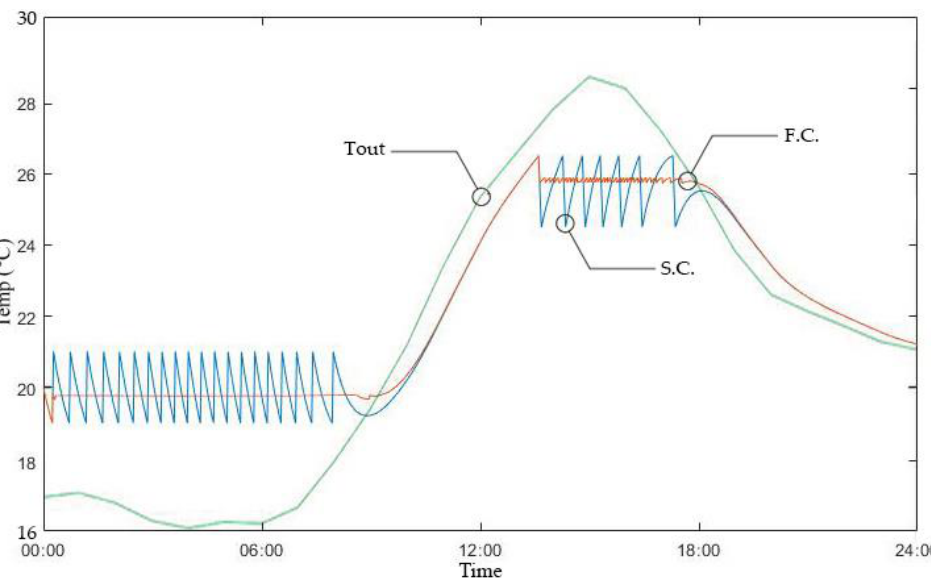
Figure 5. Comparison of T room between single-switch controller (SC) and fuzzy controller (FC).